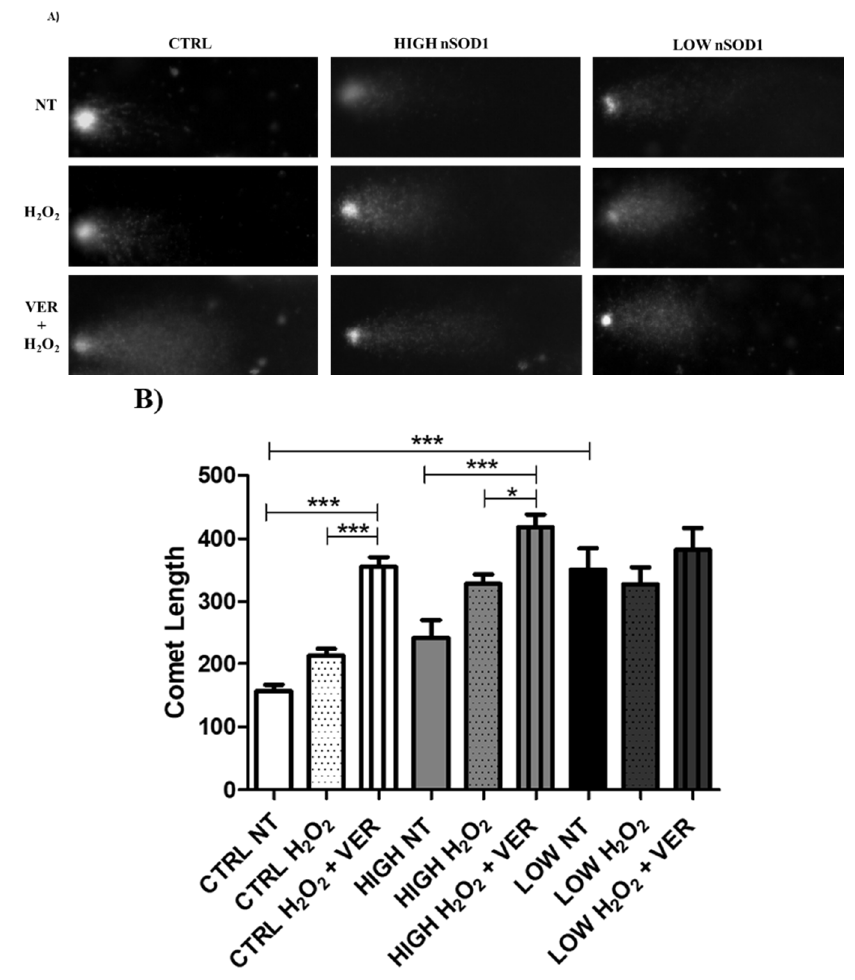
Figure 7. HSP70 is involved in DNA damage protection in PBMCs of sALS patients. ( A ) Protective role of nuclear SOD1 against DNA damage in PBMCs. Controls ( n = 2) and high- ( n = 2) and low- nSOD1 ( n = 2) PBMCs underwent basal evaluation (NT: not treated) or H 2 O 2 (5 min; 500 µM) treat- ment followed by recovery or H 2 O 2 (5 min; 500 µM) + VER (1 h; 50 µM) treatment followed by re- covery. ( B ) Comet assay quantification by comet length. Data were analyzed by ANOVA (number